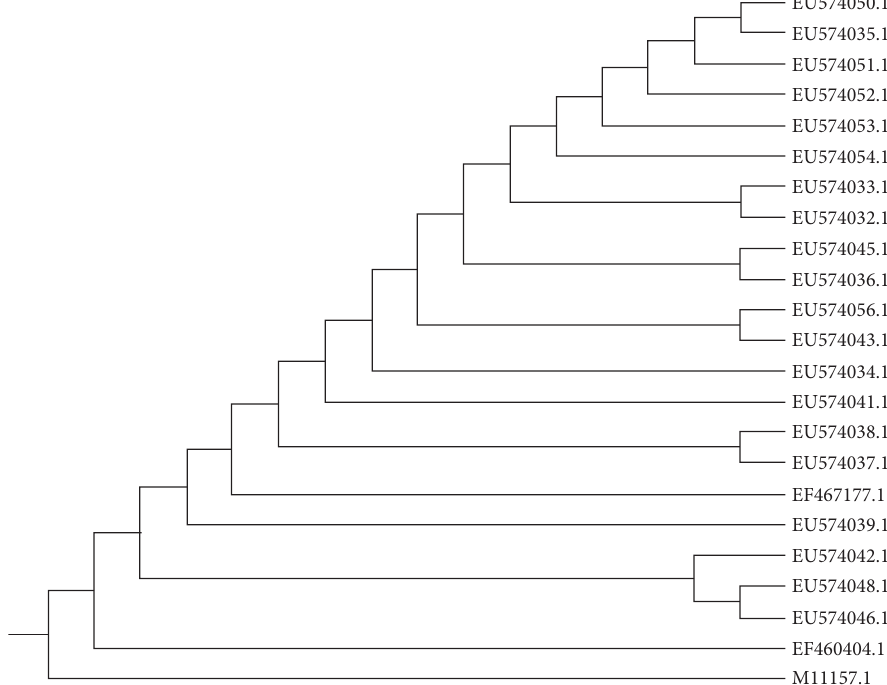
Figure 4: Genetic relationship of the RVFV strains used during the alignment of M segment sequences using the MEGA 11 version 11.0.11 tree explorer program. Table 2: Details of the RT-LAMP Glycoprotein gene primer set for rapid and real-time detection of RVFV. Primer’s